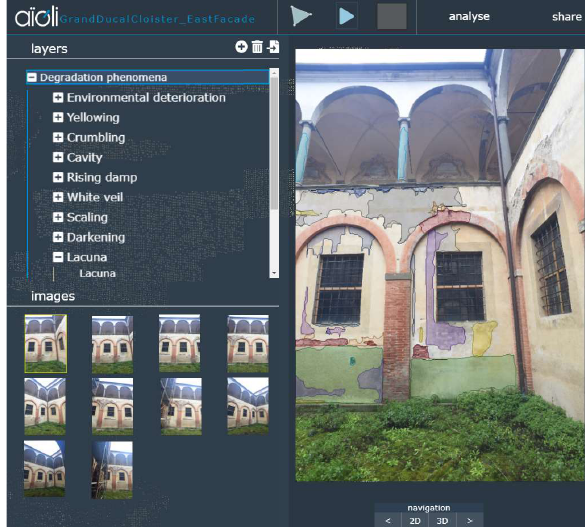
Figure 5. Insertion of different layers of degradation phenomena on Aïoli